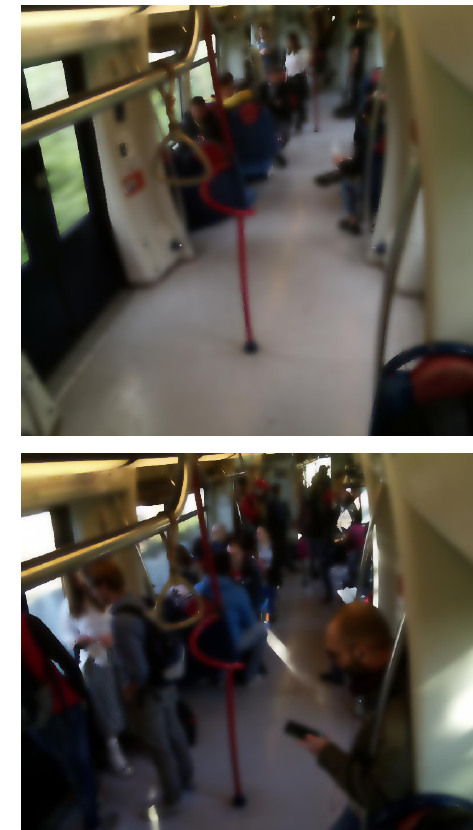
Figure 4. ShanghaiTech part B crowd images [14].